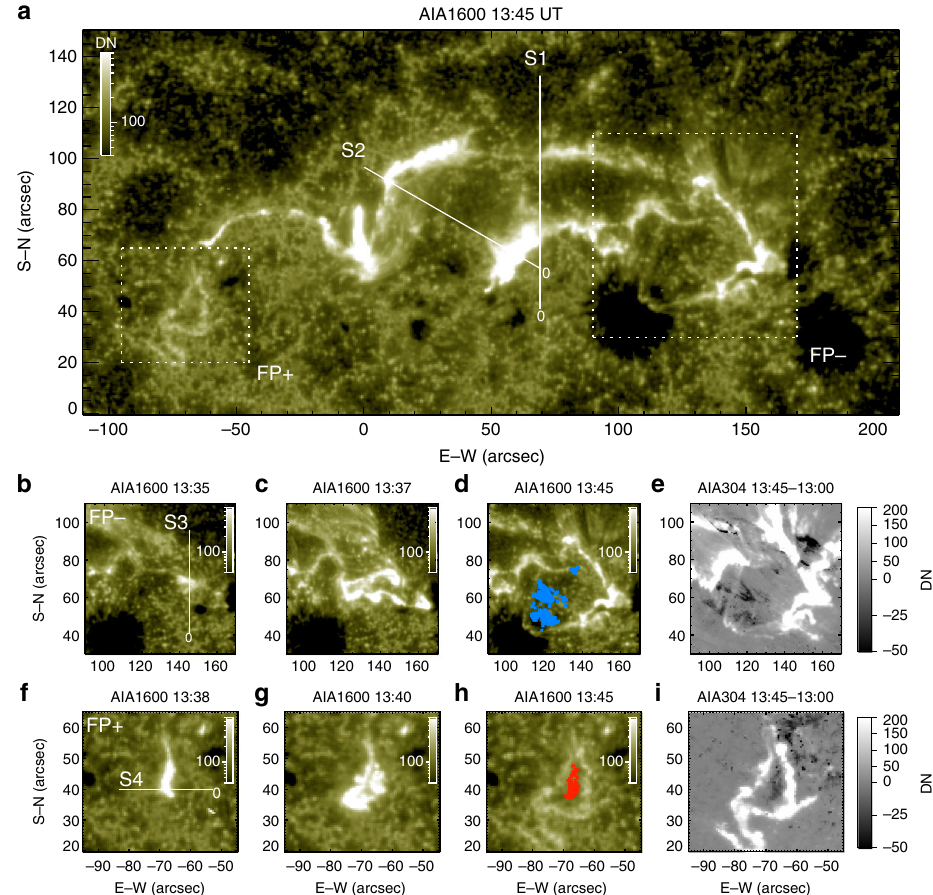
Fig. 2 Formation and evolution of the magnetic fl ux rope ’ s feet in 1600 Å. a Shows the morphology with two irregular bright rings (highlighted by rectangles) attached to the far ends of fl are ribbons. The footpoint associated with negative polarity (FP − ) is shown in b – e and that associated with positive polarity (FP+) in f – i . e , i Show dimming in 304 Å base-difference images. The dimmed pixels within FP − and FP+ are replotted in d , h in blue and red colors, respectively. Four virtual slits (S1 – S4) are indicated in a , b , f , with their starting point marked by ‘ 0